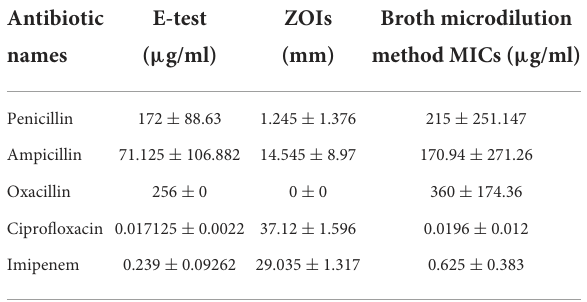
TABLE 1 Confirmation of antibiotic resistance profile of E. coli against different antibiotics using different tests. Antibiotic